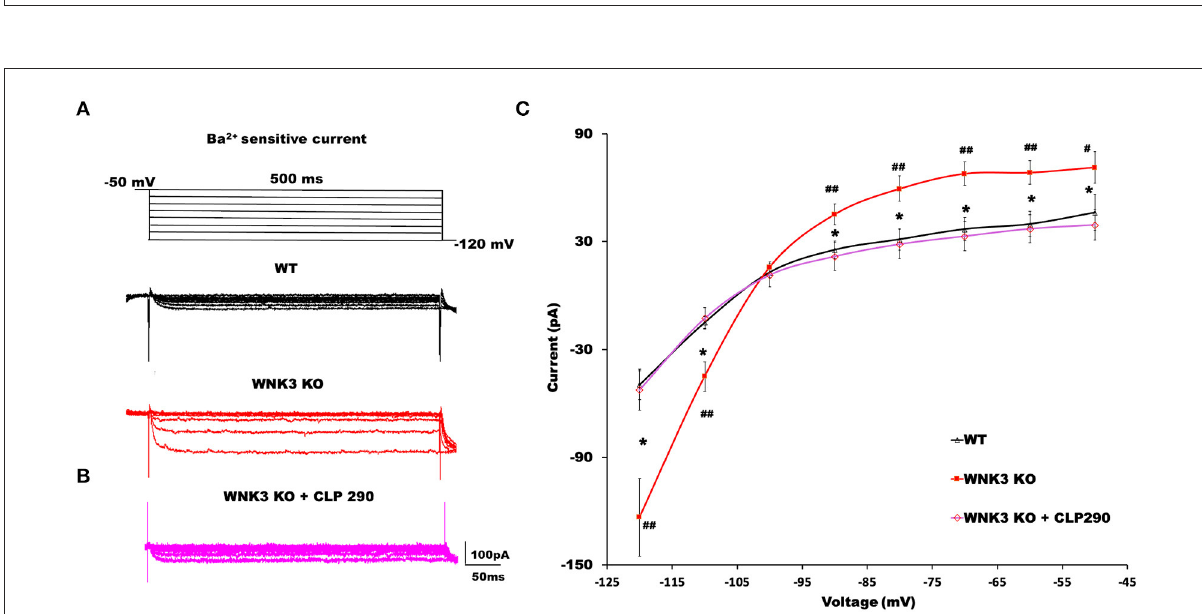
FIGURE5 KCC2 activator CLP290 reverses increased IRK currents in WNK3 KO layer V pyramidal neurons. (A) Representative traces of Ba 2 + -sensitive inward rectifying potassium (IRK) currents from layer V pyramidal neurons of the mPFC. Upper panel illustrates the voltage clamp protocol. WT neuron (black), WNK3 KO neuron (red). (B) Representative trace of Ba 2 + -sensitive inward rectifying potassium (IRK) currents from WNK3 KO layer V pyramidal neurons after preincubation with CLP 290 (magenta). (C) I-V relationship of IRK currents recorded from layer V pyramidal neurons in the mPFC. Plots of mean IRK currents at different voltages are labeled as follows: WT (solid black line; n = 11 cells, 4 mice); WNK3 KO (solid red line; n = 12 cells, 4 mice); and WNK3 KO after preincubation with CLP290 (30 µ M) (magenta; n = 12 cells, 4 mice). Data are represented as mean ± SEM ( ANOVA, post-hoc R-E-G-W F test . ## P < 0.01, # P < 0.05, * P <